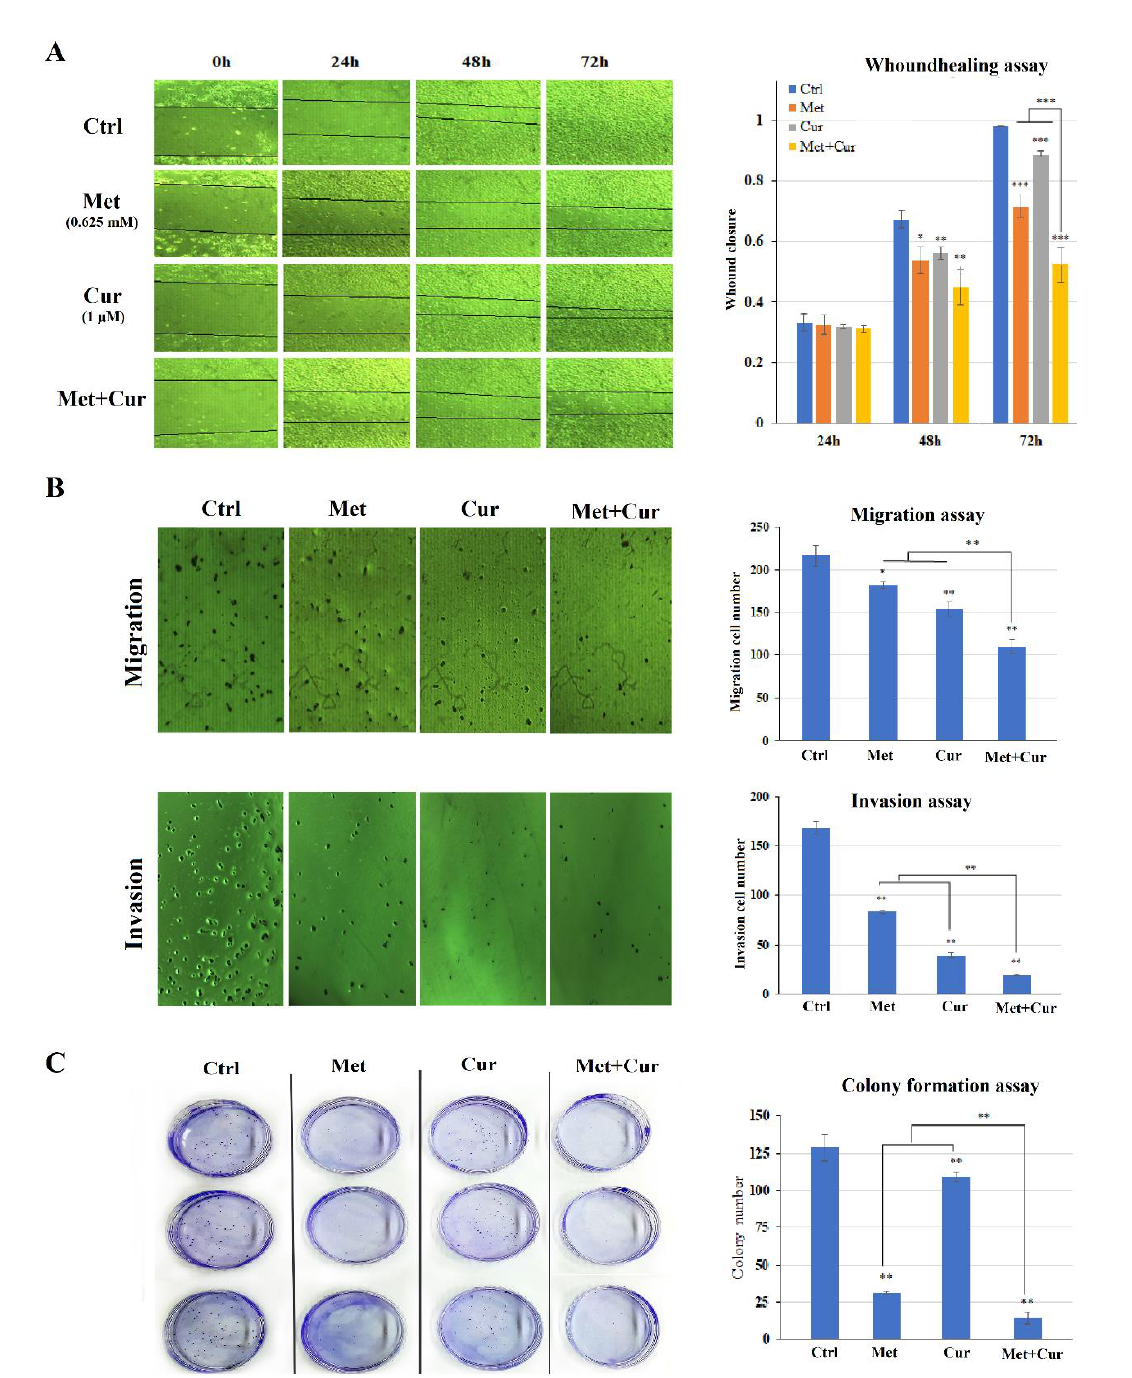
Figure 2: Combination of metformin (Met) and curcumin (Cur) synergistically inhibits metastatic poten- tial in AGS cell line compared to the control group (Ctrl). ( A ) Migration of AGS cells treated with metfor- min (0.625 mM), curcumin (1 μM), and combination (0.625 mM metformin + 1 μM curcumin) for 24, 48, and 72 hours was examined through wound healing assay by the aid of ImageJ software. ( B ) Cell mi- gration and invasion were inspected via transwell method (without matrigel and with matrigel coating, respectively) 24 hours after treatment with metformin (0.625 mM), curcumin (1 μM), and their combina- tion. ( C ) Observation of tumorigenic characteristics of AGS cells treated with metformin (0.625 mM), curcumin (1 μM), and their combination via colony formation assay during 12 days. Each column in graphs represents mean ± SD for three independent experiments and compared with untreated control determined by the ANOVA test. *, ** and *** show significant differences at p<0.05, p<0.01 and p<0.001,